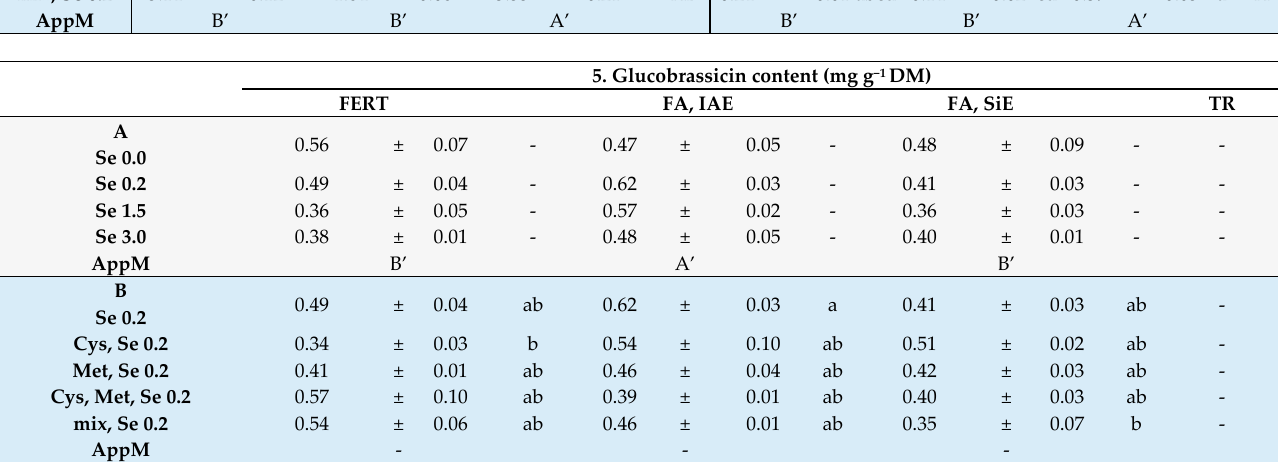
Table 4. Overview of the performance of the application mode per treatment for the applied Se concentrations, in terms of percentage difference with the control plants (Se0.0/FERT). The